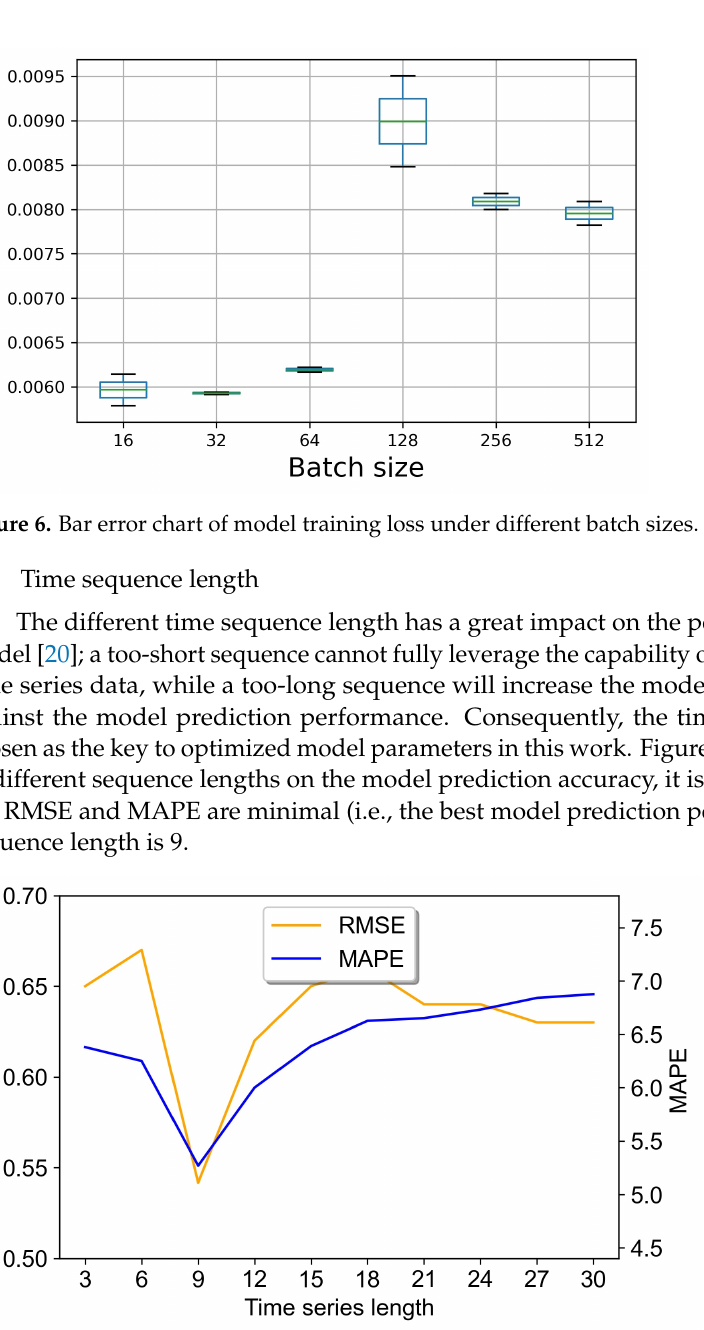
Figure 7. The influence of different sequence lengths on the model performance (batch size = 32, lr = 0.001, n =